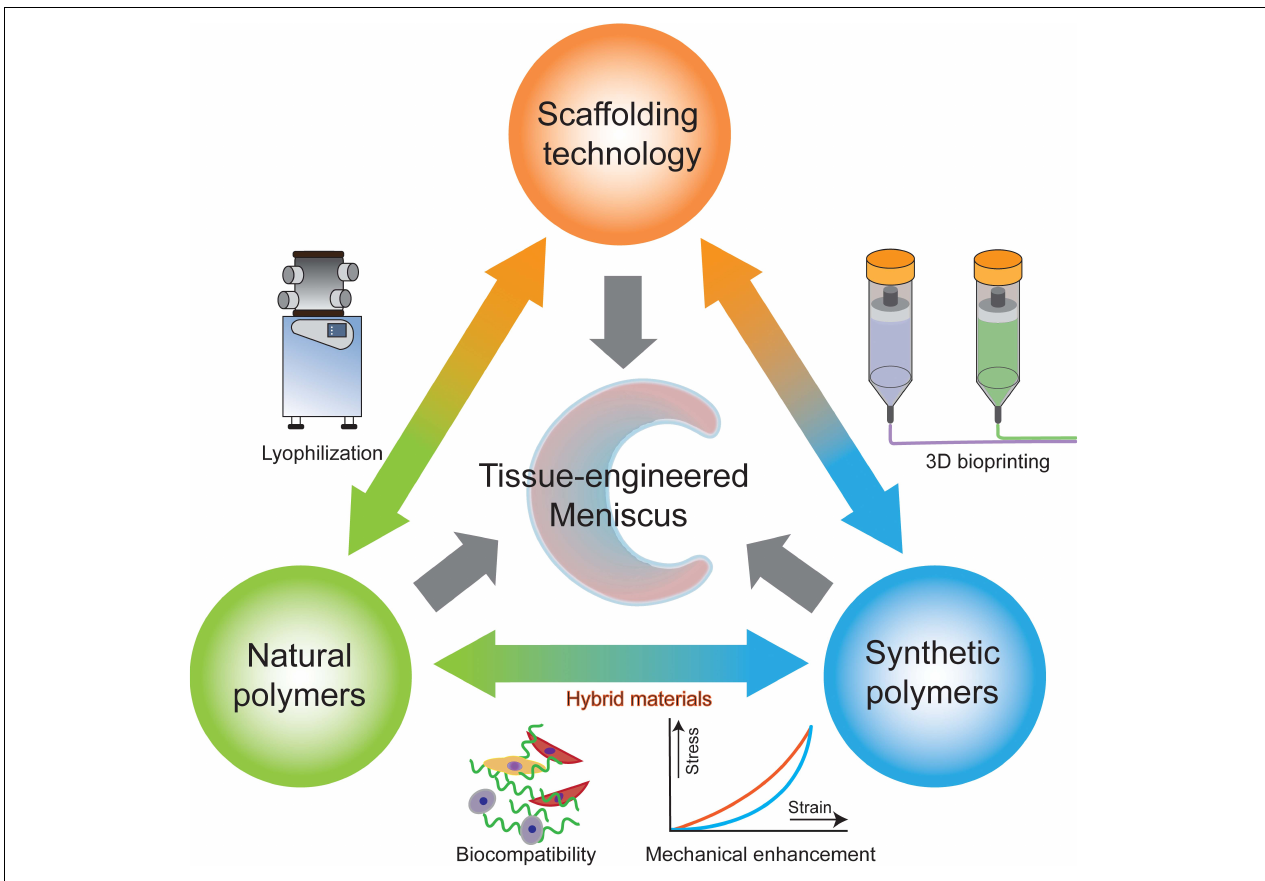
FIGURE 4 | Key factors of polymeric scaffolds and their